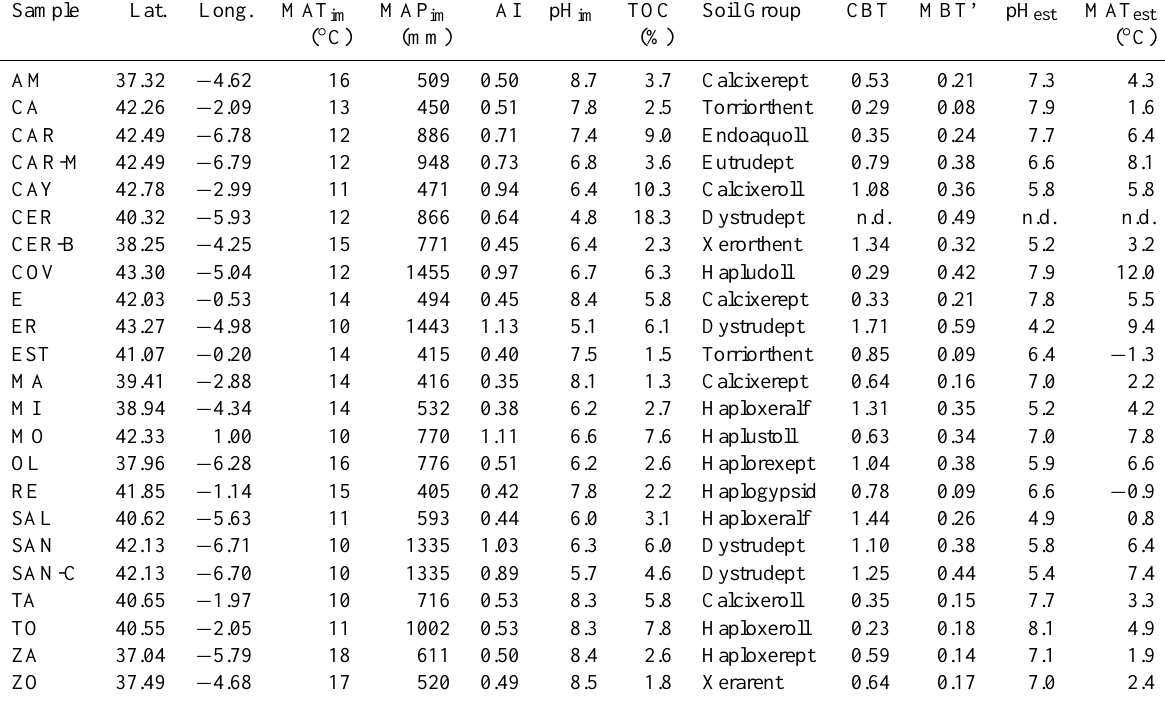
Table 1. Sample code and coordinates, instrumentally measured mean annual temperature (MAT im ) , instrumentally measured mean annual precipitation (MAP im ) , aridity index (AI), instrumentally measured pH (pH im ) and TOC (%). Soils were classified according to Soil Taxon- omy (Soil Survey Staff, 2010) at group level. The calculated CBT and MBT’ values, as well as derived pH (pH est ) and MAT (MAT est ) , are also